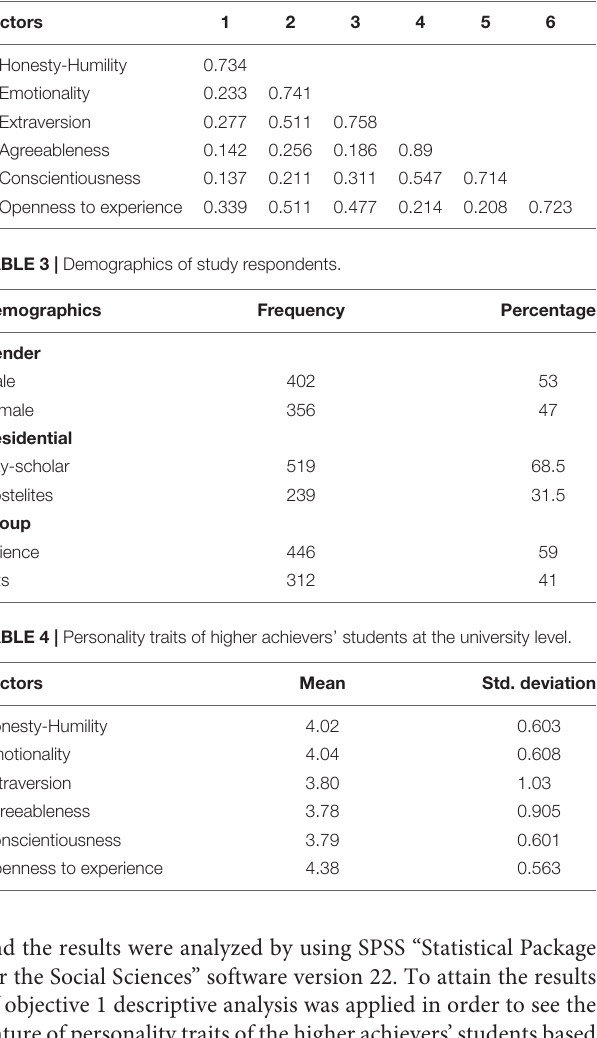
TABLE 2 | Fornell–Larcker criterion.